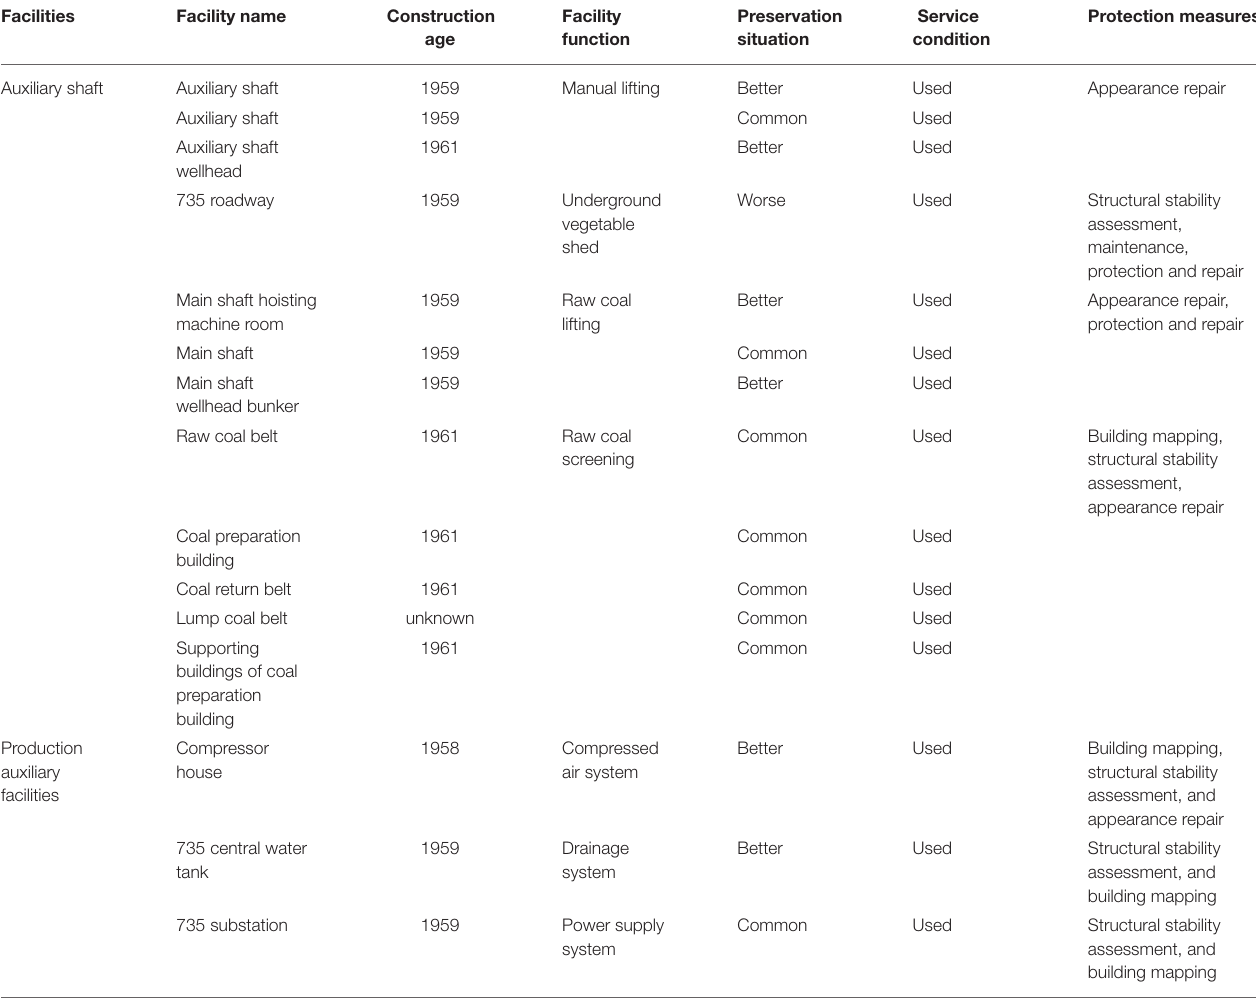
TABLE 1 | Production facilities list of Wangshiwa Coal Mine.